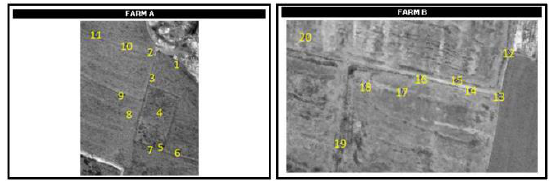
. Figure 7. Sampling quadrants in Farm A and B